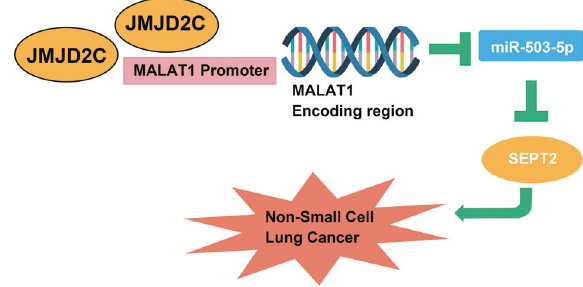
Fig. 6 The network of JMJD2C. A schematic model of JMJD2C- mediated MALAT1/miR-503-5p/SEPT2 regulatory network in